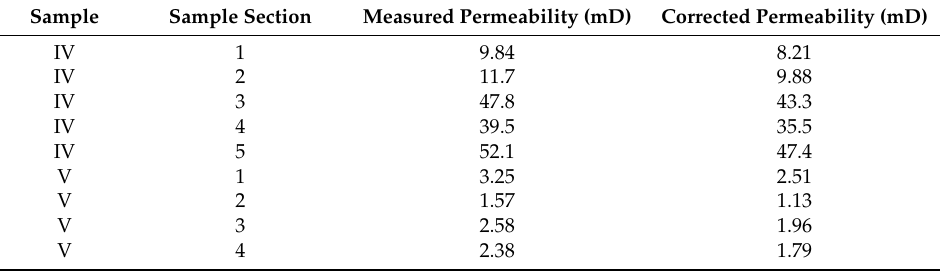
Table 1. Permeability values measured at five positions within the samples.